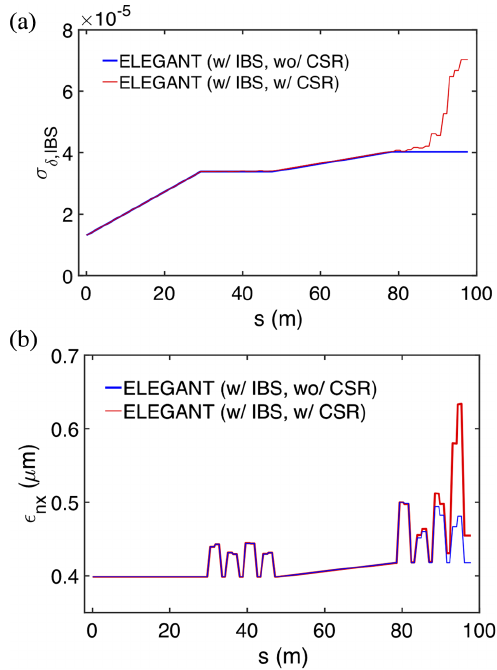
FIG. 12. The evolution of (a) the slice energy spread and (b) the normalized emittance along s . The red lines are for the case with IBS and with (steady-state) CSR; the blue lines without IBS but with (steady-state) CSR. It can be seen that, for (a), about 400% increase for red and ∼ 200% increase for blue. For (b), only 5% increase for blue and 12% increase for red. Here, only the central slices in the bunch are taken for calculation of the slice energy spread and emittance. Those slices close to the bunch head and tail are